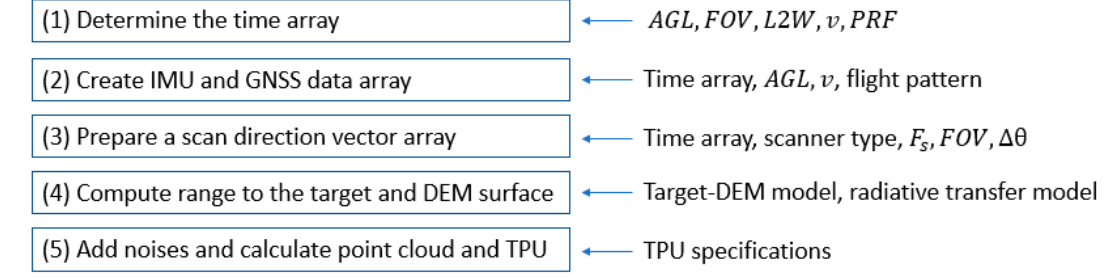
Figure 4. Preparation of orientation of simulated flight lines. The point clouds in Figure 4 demonstrate the resultant swaths for two examples (cross pattern with circular scanner and slant-cross pattern with linear scanner). The GNSS position array is prepared for four preset flight patterns in Figure 5, where the x-axis and y-axis represent ground coordinates in meters. The coordinates are prepared in LTF. The swath boundary of the two swaths is illustrated in red and white. The GNSS position corresponds to the dashed line located in the center of each swath. This illustration is based on a 30% swath overlap ratio. Figure 5. Preset flight patterns of the airborne lidar simulator. The next step is to create a direction vector of the propagating pulse in the SBF. The scan angle ( θ ) array is prepared first using scanner type, 𝐹 (cid:3046) , 𝐹𝑂𝑉 , and the scan angle offset, ( ∆ θ ). Then the direction vector in SBF for the Galvo-mirror and circular scanner is given, respectively, as follows: 𝒅 (cid:3017)(cid:3020)(cid:3003)(cid:3007) = [0, 𝑠𝑖𝑛𝜃, 𝑐𝑜𝑠𝜃] ,